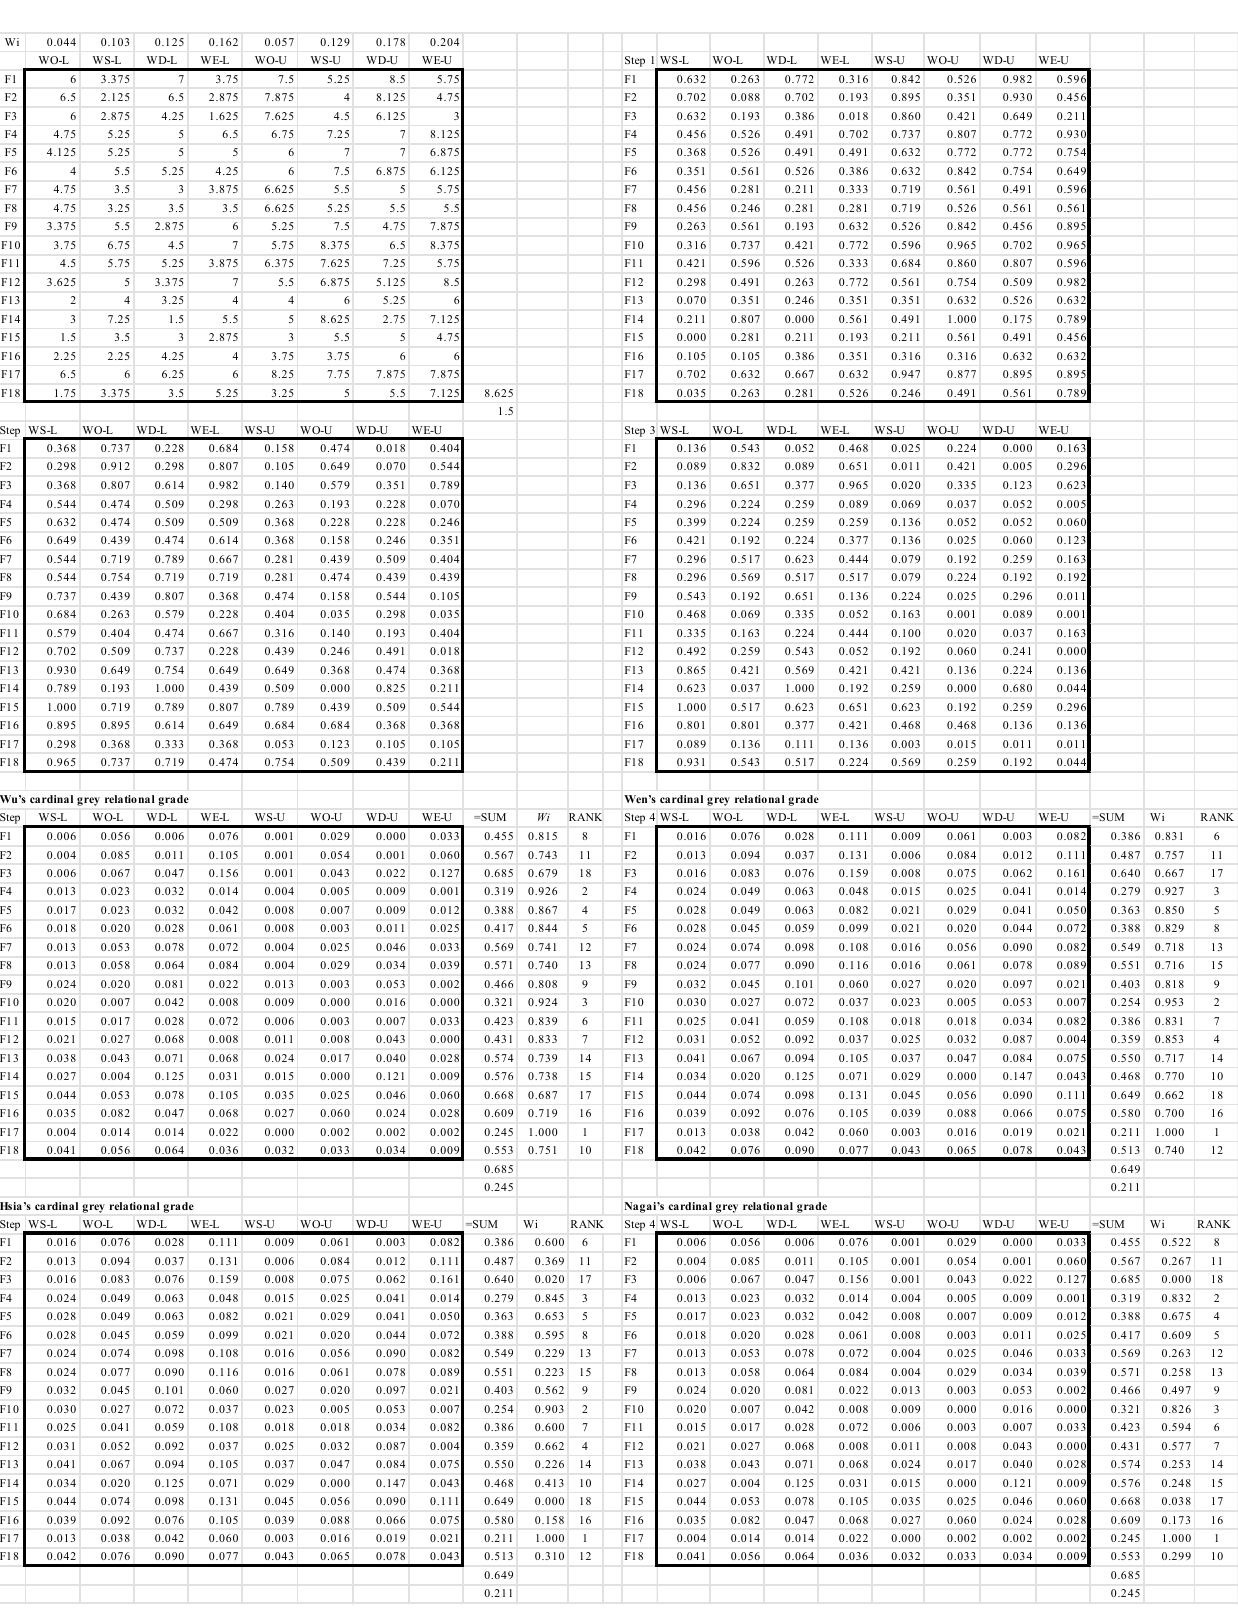
Figure A3. Four different GRA calculation steps for ranking by EXCEL.